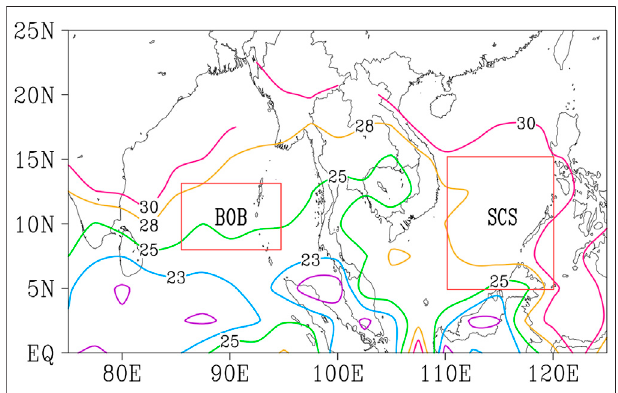
FIGURE1| Thepentad-isochronesindicatingtheonsetprocessofASM for 1958 – 2018. The area encircled by red solid lines represents the selective BOBSM region and SCSSM region,